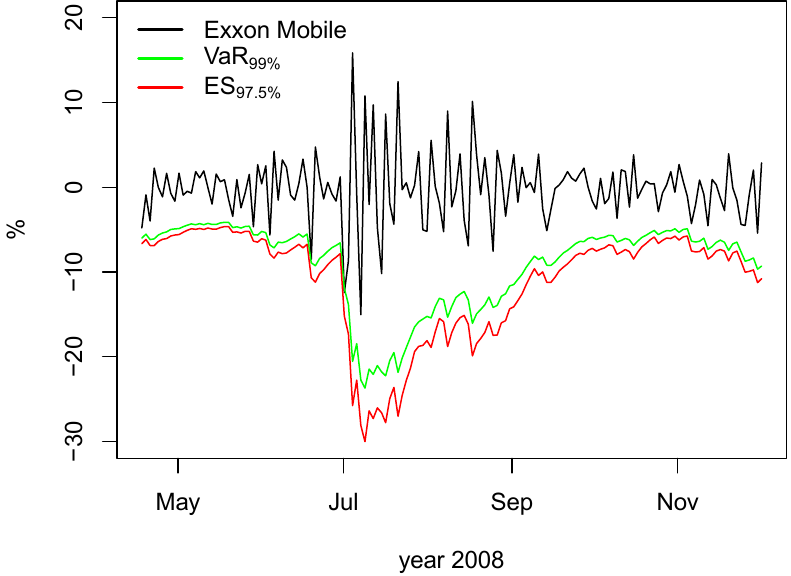
Figure 4. The di ff erence in risk measures in Epistar and Exxon Mobil stock returns. Figure 4. The difference in risk measures in Epistar and Exxon Mobil stock returns.